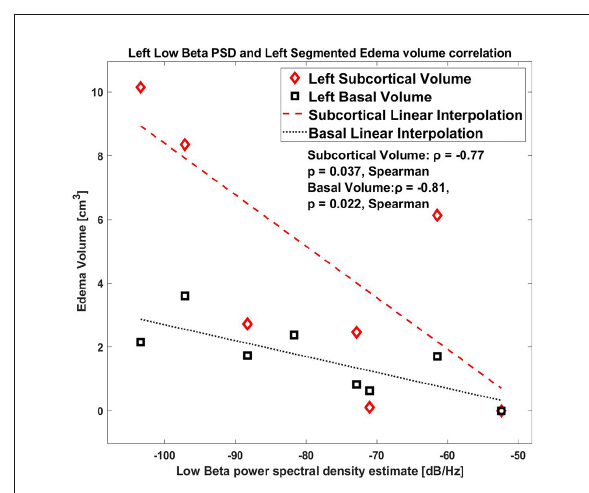
FIGURE4 Correlation between low beta band power and the edema volume for the left hemisphere with Basal and Subcortical